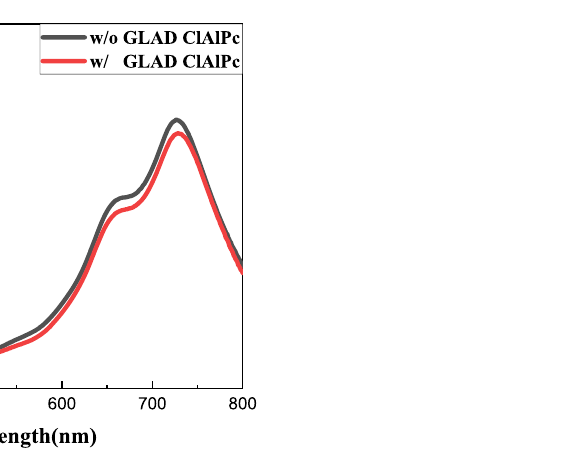
Figure 6. Optical absorption spectrum of ITO/ClAlPc/ClAlPc:C60/C60 and ITO/ClAlPc/ClAlPc:C60/ ClAlPc(GLAD)/C60